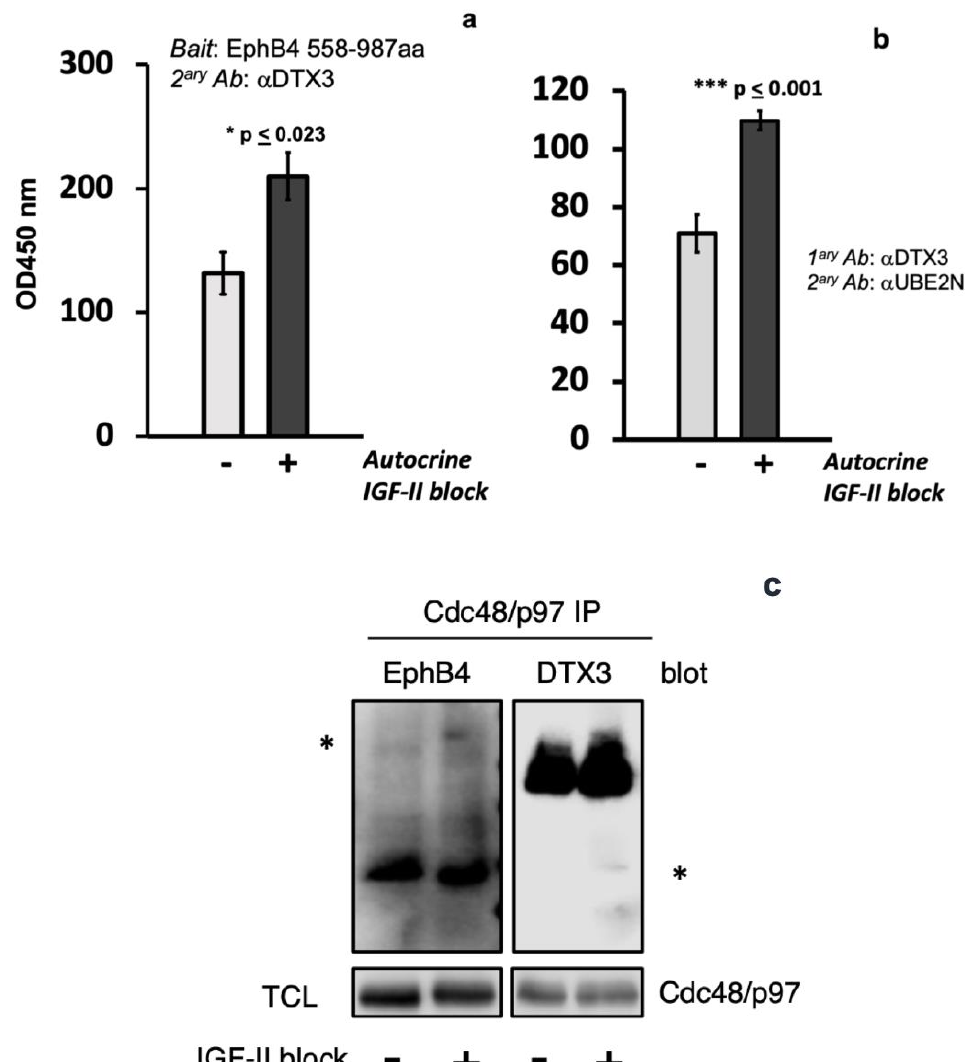
Figure 3. Independent co-purification of DTX3 with EphB4 C-tail, UBE2N, and CDC48/p97 upon autocrine IGF-II block in MSTO211H. Solid phase pull down-EIA ( a ), ELISA ( b ), and immunoblot of co-immunoprecipitated protein ( c ) were used to confirm independent physical interaction of native proteins from MSTO211H lysates. The asterisks indicate the specific expected bands. Quantitation for EIA and ELISA represents mean + s.e.m. of six measurements ( n = 6). Statistical analyses were performed and p values calculated using Student’s t -test with unequal variances.